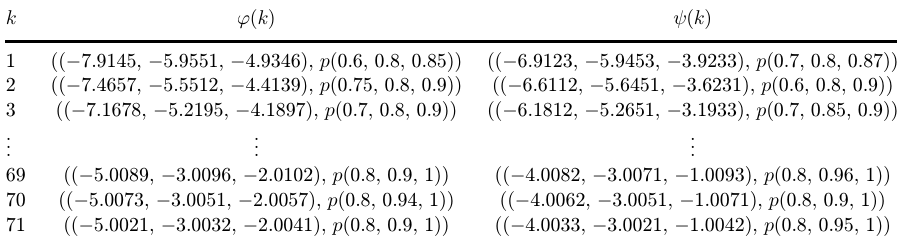
Table 1. Results of approximating the Z -number solutions ’ ð k Þ and ð k Þ with an example feedback neural network obtained during the experiments.